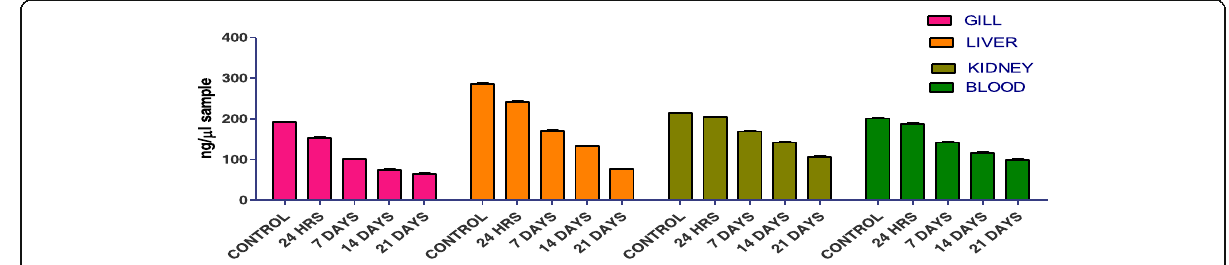
Fig. 12 DNA content in tissues of C. carpio , on exposure to